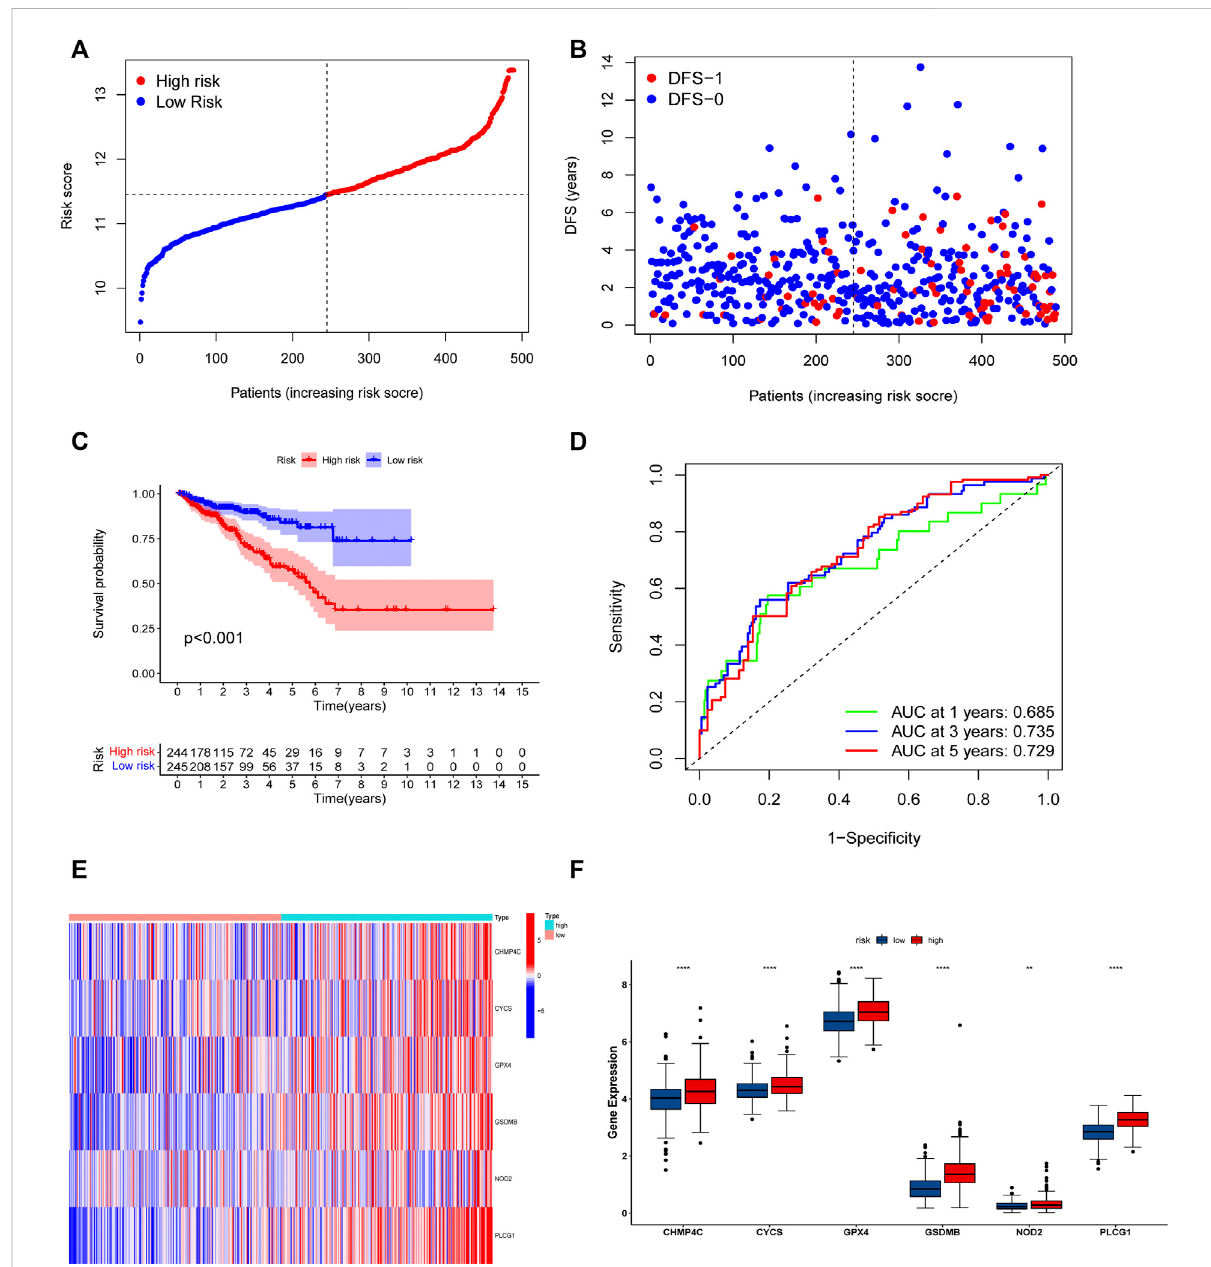
FIGURE 5 Riskmodelbasedonthe6hubgenesinTCGAcohort. (A) Distributionofpatients ’ riskscores. (B) Distributionofsurvivalstatusofpatientsinhigh and low risk groups. (C) The KM curves in high and low risk groups of patients. (D) 1, 3, 5-year ROC curve. (E,F) The heatmap and bar graph of expression of 6 key genes in high and low risk